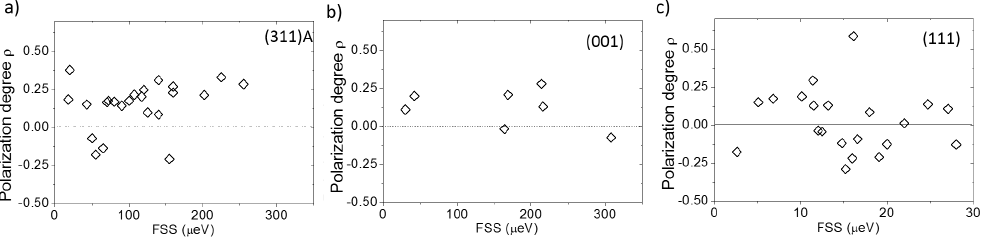
Figure 8. ( a ) Polarization degree of the X PL line as a function of the corresponding FSS for QDs grown on the (311)A surface for the sample described in [69]. ( b ) Same as for (a) but for (001) QDs for the sample described in reference [71]. ( c ) Same as for (a) but for (111)A